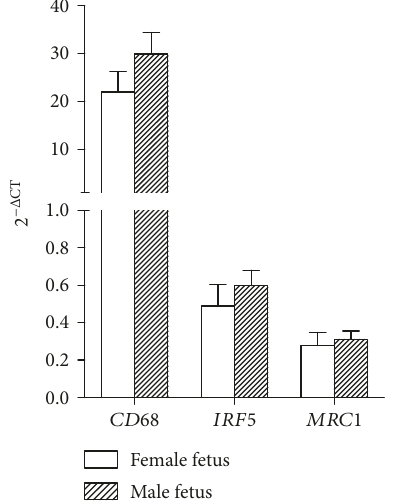
Figure 2: mRNA expression of macrophage markers in the fi rst- trimester human decidual tissue. Data are mean ± SEM mRNA target gene expression normalized to housekeeper gene HPRT , in the decidual tissue from pregnancies with a female fetus (open bars, n = 8 ) and pregnancies with a male fetus (black bars, n = 8 ). Comparison between groups was evaluated using Mann – Whitney U test with Bonferroni multiple comparison